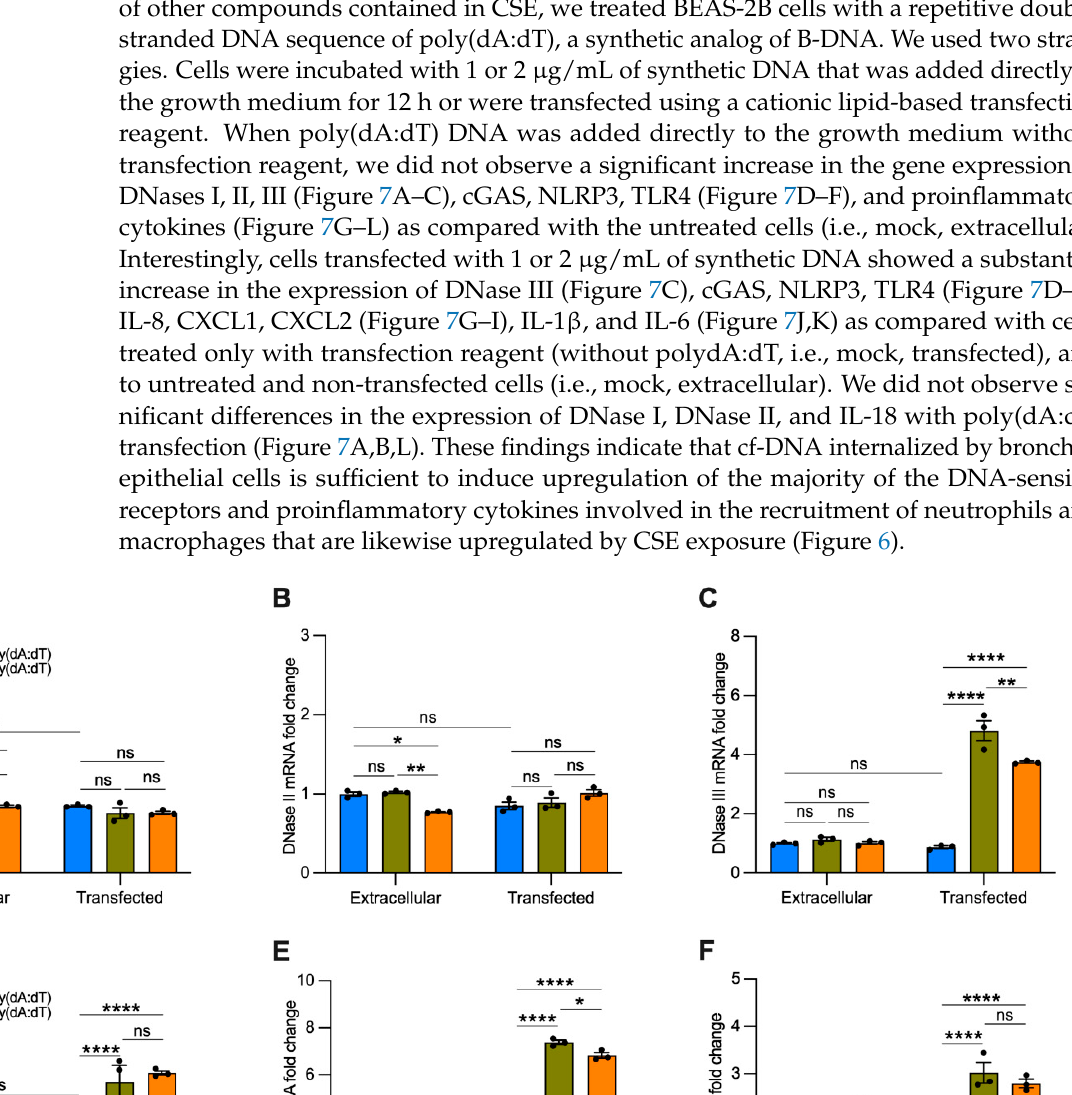
Figure 7. Transfected synthetic DNA upregulates the expression of DNase III, DNA ‐ sensing recep ‐ tors, and cytokines involved in neutrophil and macrophage recruitment. Bar graphs reporting the gene expression in cells exposed for 12 h to 1 or 2 μ g/mL of synthetic DNA added directly to the growth medium (extracellular) or transfected using a cationic lipid ‐ based transfection reagent (transfected): ( A – C ) DNases I ‐ III; ( D – F ) cGAS, NLRP3, TLR4; ( G – I ) IL ‐ 8, CXCL1, CXCL2; ( J – L ) IL ‐